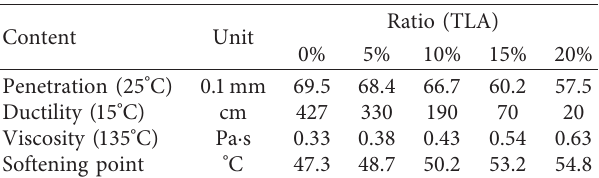
Table 10: Properties of asphalt mixture with different ratios of